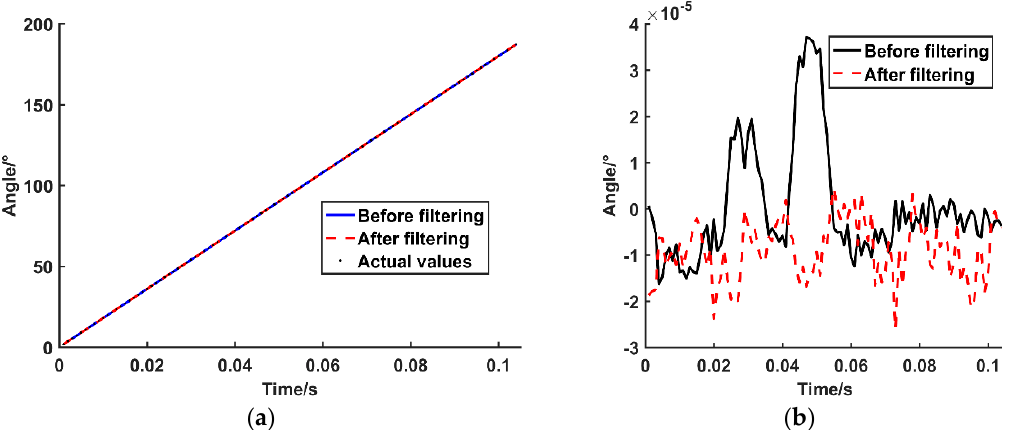
Figure 12. Result comparison before and after filtering. ( a ) The encoder rotation angles obtained by ATS method before and after filtering. ( b ) Angular deviation between calculated results and actual values before and after filtering.